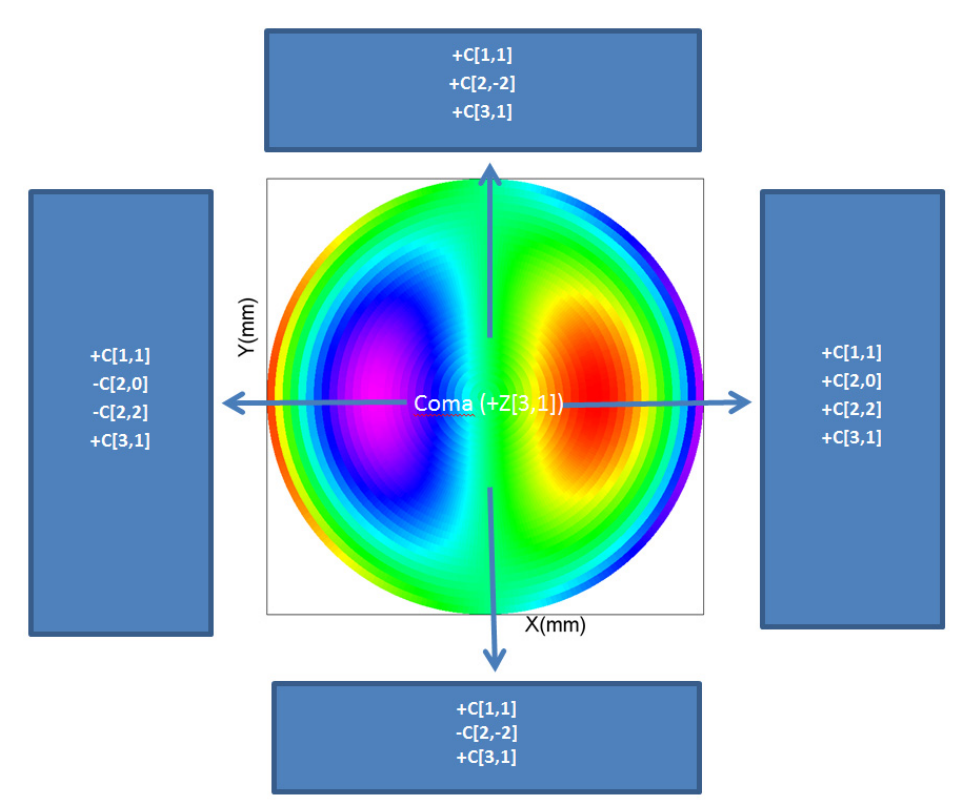
Figure 6. Effect of translation in horizontal coma (C[3,1]) in positive and negative direction in the orthogonal principal axes. Notice that translation in the horizontal axis results in induction of horizontal tilt (C[1,1]), defocus (C[2,0]), cardinal astigmatism (C[2,2]) and horizontal coma (C[3,1]); while translation in the vertical axis results in the induction of horizontal tilt (C[1,1]), oblique astigmatism (C[2, − 2]) and vertical coma (C[3, − 1]). In addition, in the horizontal axis, the direction of translation effects the sign of the induced defocus (C[2,0] and cardinal astigmatism (C[2,2]); while in the vertical axis, the direction of translation effects the sign of the induced oblique astigmatism (C[2, − 2]) only.